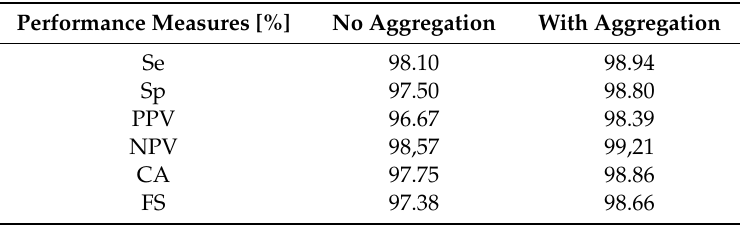
Table 5. The AF detection performance obtained without and with aggregation process, which was optimized for the window width of 110 beats and percentage threshold equal to 55%, calculated for all 1,221,033 reference annotated heartbeats.